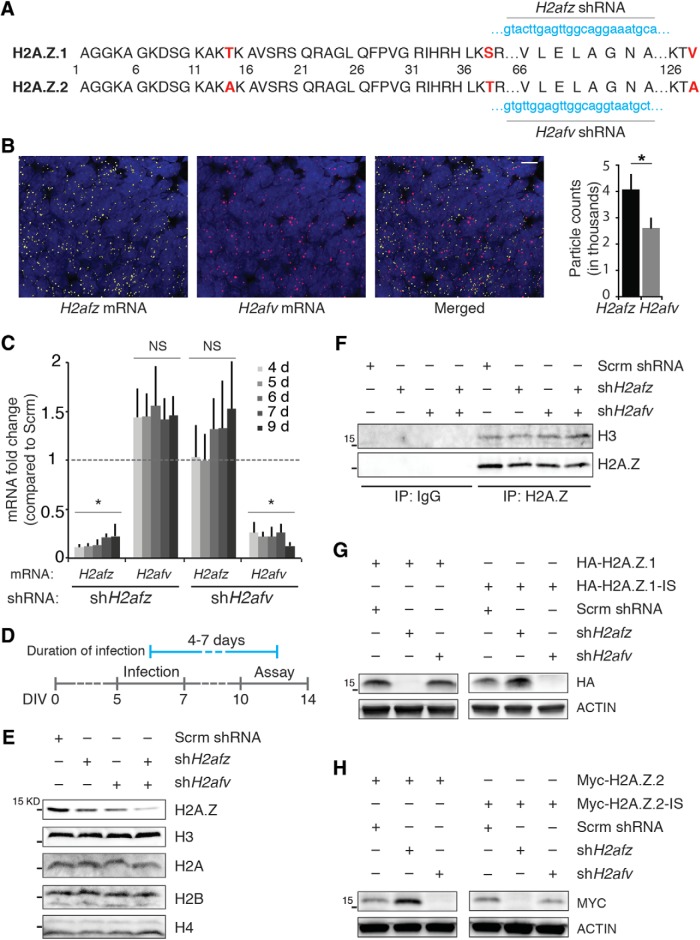
Validation of H2A.Z hypervariant-specific RNAi. A, H2A.Z.1 and H2A.Z.2 amino acid sequences are depicted where three different amino acid residues are indicated in red. The target sequences of shH2afz and shH2afv are noted in blue. B, left, Representative images of smFISH of H2afv and H2afz in E18 rat cortex. Right, Quantification of H2afz and H2afv molecules; particle count per 212 μm2. N = 3, *p < 0.05 (one-tailed unpaired t test). Scale bar, 10 μm. C, Cortical neurons in culture were infected with lentiviruses delivering either shH2afz or shH2afv and total RNA was collected after indicated number of days. Compared to control neurons, changes in H2afz and H2afv mRNA levels were determined by qPCR, normalized to Gapdh mRNA levels (internal control) and are depicted here as fold change. NS, not significant. *p < 0.05. N = 3–6. D, Timeline of infection and treatment for all assays performed in dissociated cortical neurons. Cells were infected with lentiviruses between 5 and 7 d after plating (gray line), and assays were performed between 4 and 7 d after infection (between DIV10 and DIV14; blue line). E, Total acid-extracted histone from neurons infected with lentiviruses delivering either shH2afz or shH2afv or both for 6–7 d, resolved by electrophoresis, and blotted for indicated histone. N = 3. Note the cumulative effect of depleting both hypervariants when probed with total H2A.Z antibody. F, IP of nucleosomal H2A.Z from nuclear extract of neurons infected with lentiviruses delivering either shH2afz or shH2afv or both for 6 d resolved by electrophoresis. N = 3. G, H, Neurons were coinfected with indicated constructs for 4–5 d and nuclear extracts were resolved by electrophoresis. IS, insensitive; shRNA target regions were swapped in these constructs. N = 3.